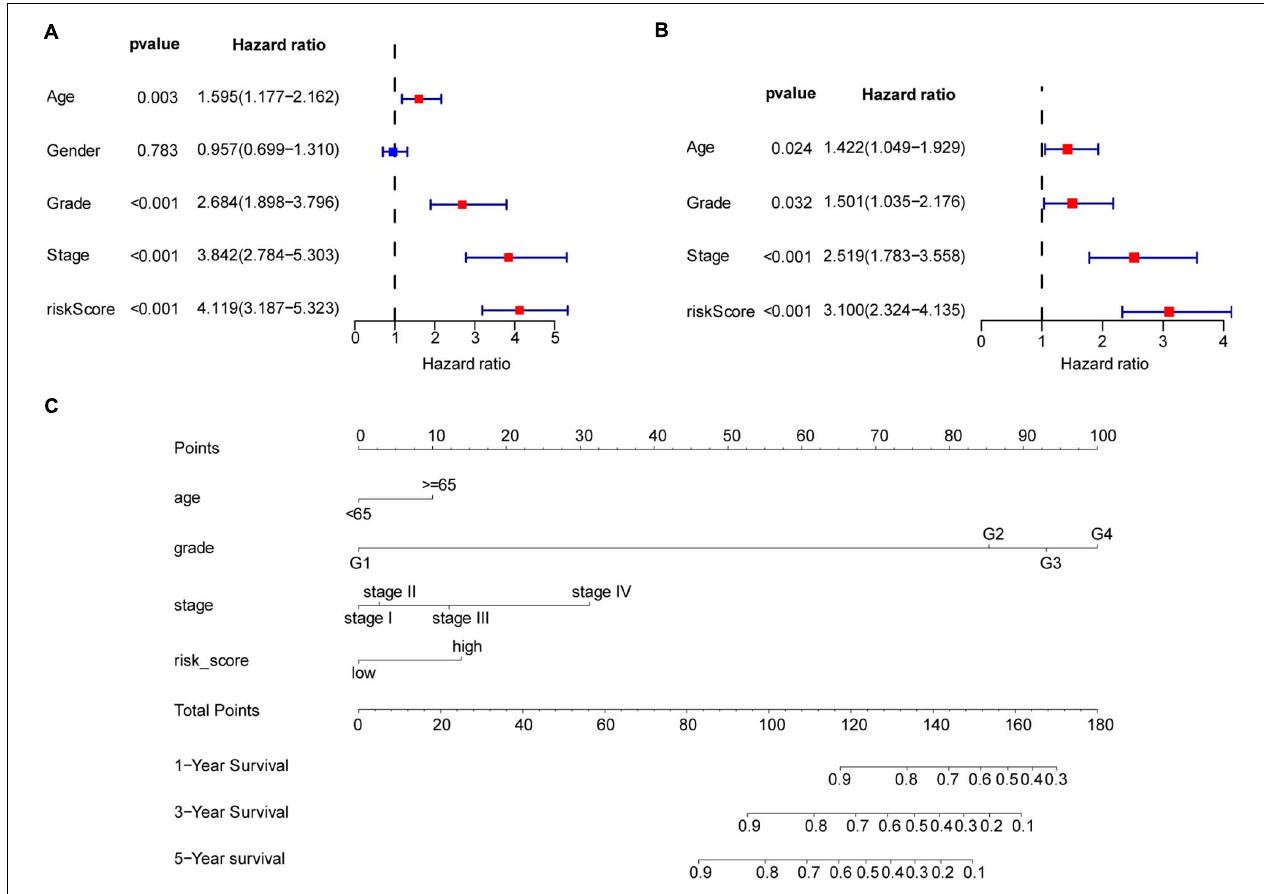
FIGURE 5 | Nomogram to predict the survival probability of patients with clear cell renal cell carcinoma (ccRCC). (A) Univariate Cox regression of clinical characteristic and risk score model. (B) Based on the results of univariate Cox regression, hazard ratio (HR), and 95% CI of multivariate Cox regression analysis, age, grade, stage, and risk score showed significant differences between the high − and low-risk groups. (C) Prognostic nomogram for predicting the survival of patients with ccRCC. Every predict factor corresponds to a score. Clinically, the corresponding score can be obtained according to the patient’s condition, and the total score can be obtained by adding each score, which corresponds to the corresponding survival